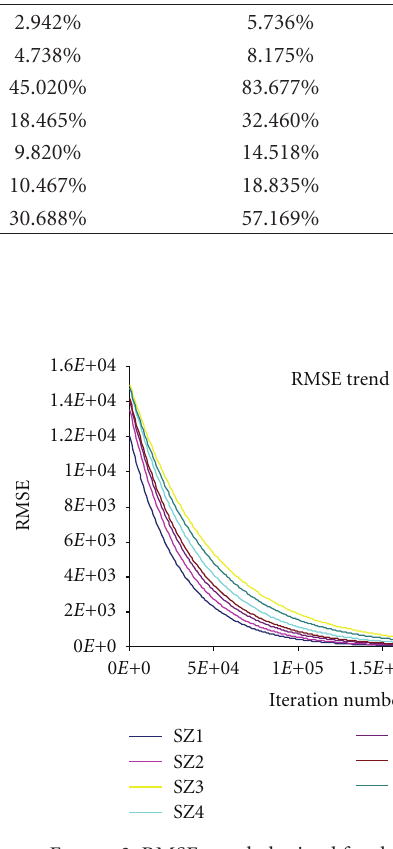
Figure 3: RMSE trend obtained for the seven